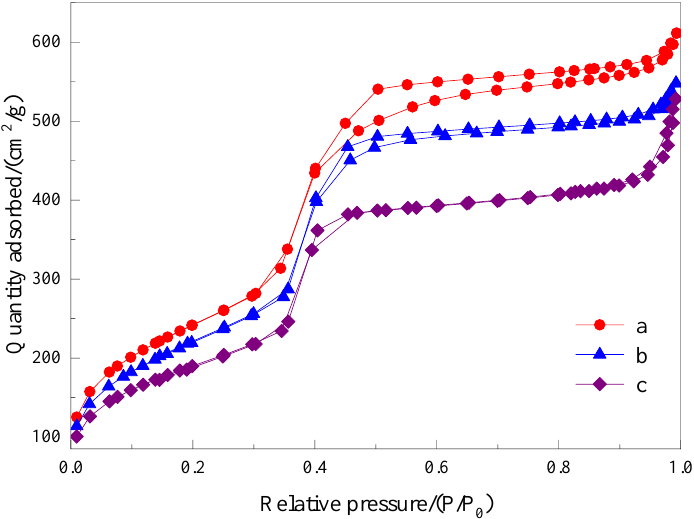
Figure 7. N 2 adsorption – desorption isotherms of the samples. a -Mesoporous material synthesized with Gemini ionic liquid surfactant [N 1116 C 3 IMC 16 ][Br] 2 as template. b -Mesoporous material syn- thesized with Gemini ionic liquid surfactant [N 1116 C 3 N 1116 ][Br] 2 as template. c -Mesoporous material synthesized with Gemini ionic liquid surfactant [C 16 IMC 3 C 16 IM][Br] 2 as template.